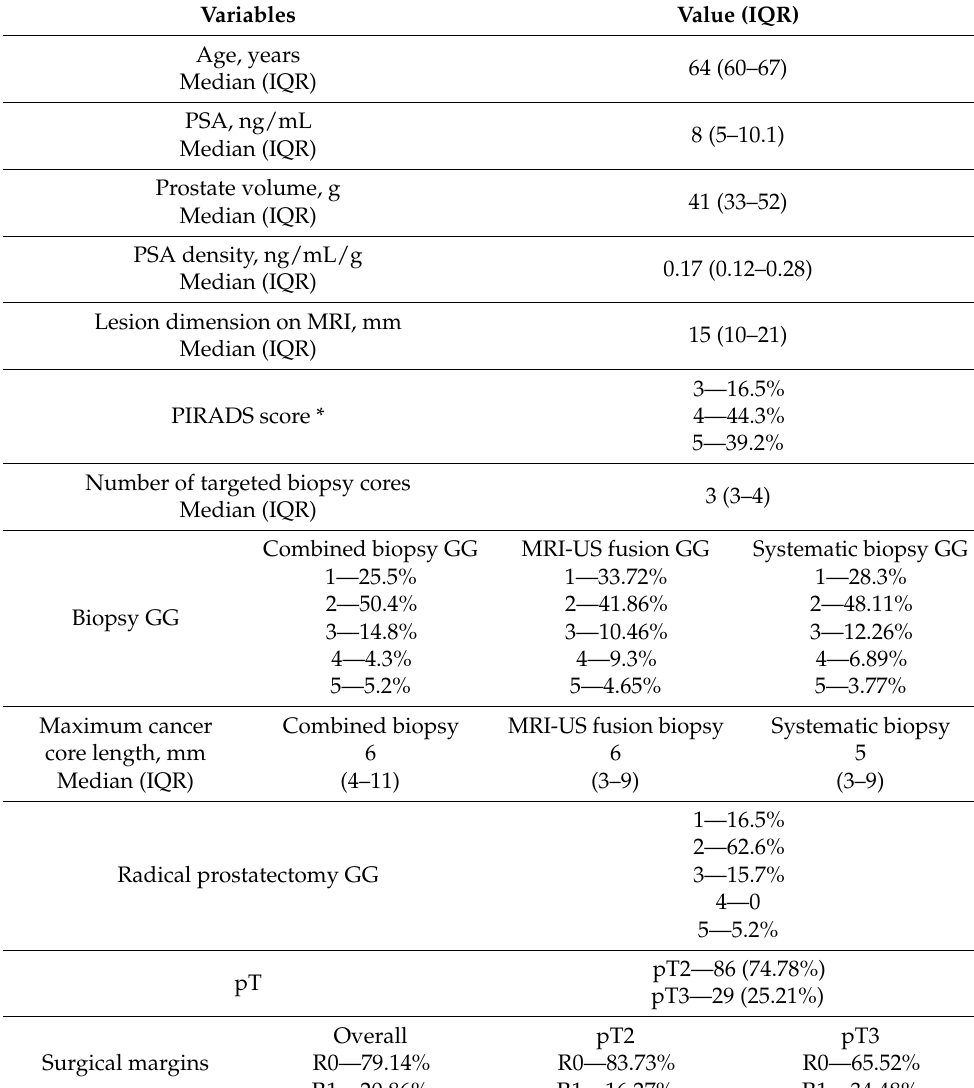
Table 1. General characteristics of the